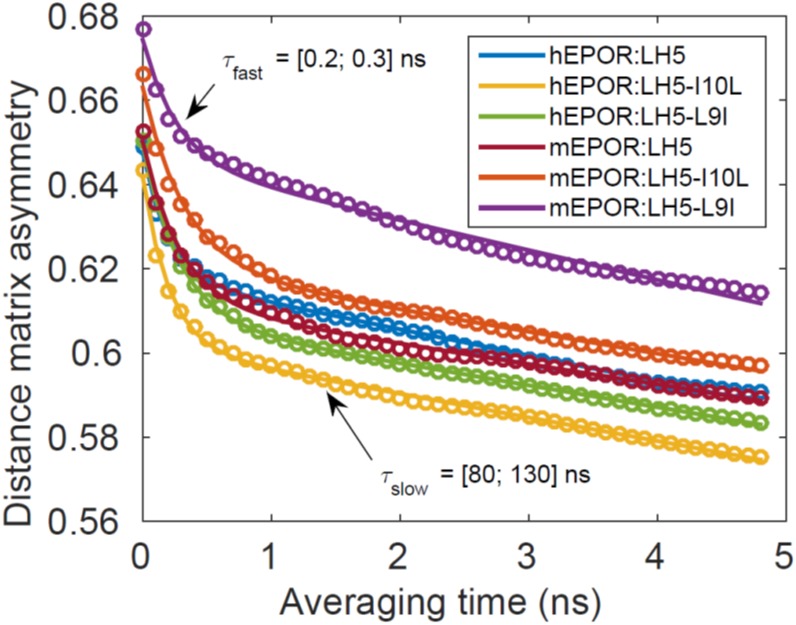
Time to approach symmetry.The figure shows plots of thedegreeofsymmetry,σn, as a function of n(expressed in units of time). In all cases, the relationship fits very well to a sum of two decaying exponentials. The time constants of the slow and fast exponentials varied relatively little from system to system, indicating that very fast averaging (time constant on the order of 1 ns) is followed by a relatively slower symmetrization process (time constant on the order of 100 ns). Although the length of each independent simulation is too short to observe complete arrival to symmetry (i.e., the plots never reach the value σn=0), all of the simulation data are entirely consistent with full symmetry arising on time scales that are inaccessible to NMR experiments.